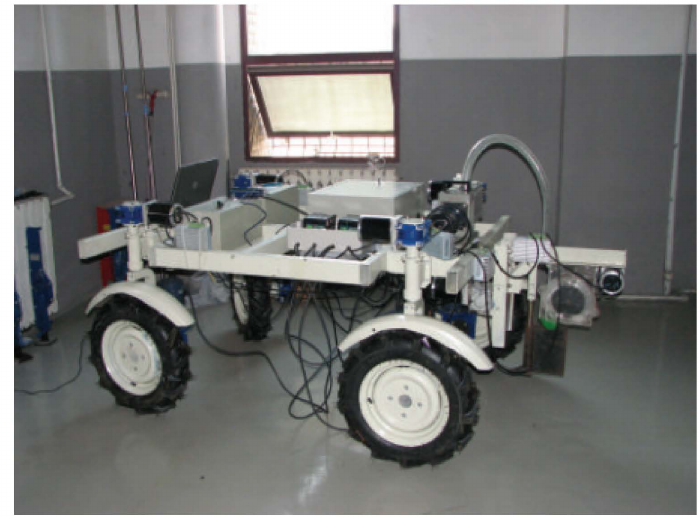
Figure 6. Wheat precision seeding robot